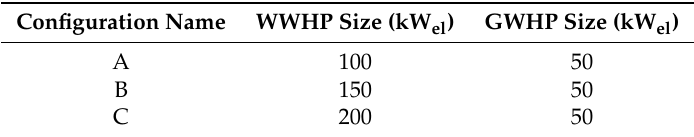
Table 3. Considered system